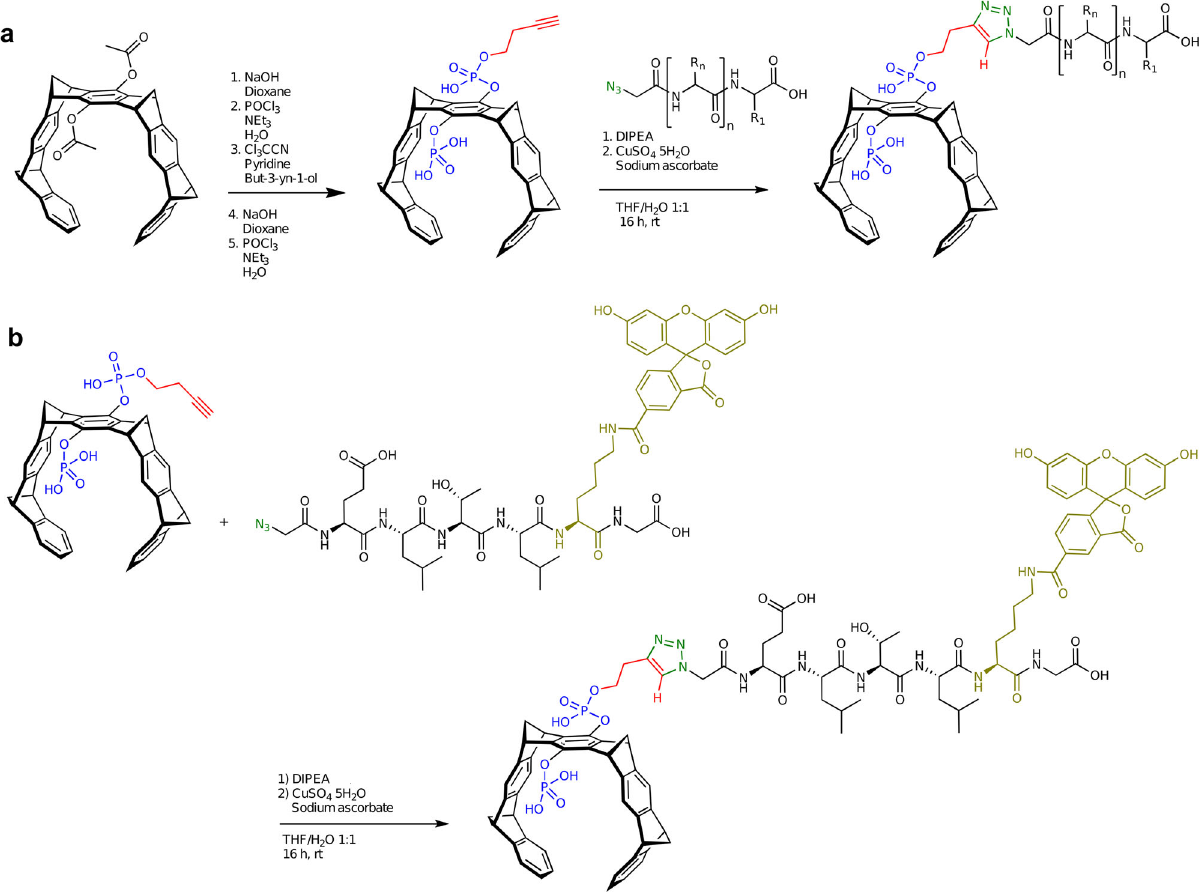
Fig. 2 Synthetic strategy leading to monofunctionalized molecular tweezers. a Introduction of one butynyl phosphate ester arm on the parent diacetoxy tweezer (TCA coupling) followed by click chemistry with N-terminal azidopeptide; b additional introduction of a fl uorescence label by adding a C-terminal Lys FAM -Gly sequence to the clicked peptide. Blue: phosphate; red: alkyne/triazole; green: azide/triazole; olive: FAM label. DIPEA N,N- diisopropylethylamine, THF 20:1 stoichiometry (correlating well with 16 accessible lysine and arginine residues in Survivin120), whereas the modi fi ed tweezers